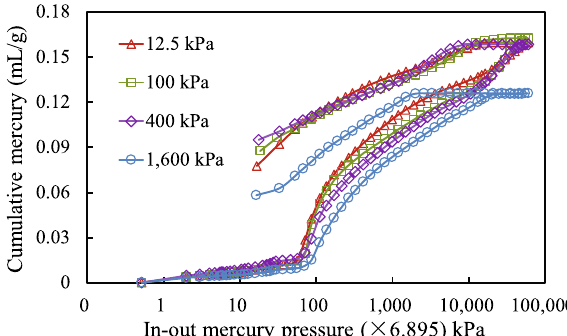
Figure 6. Relation between in–out mercury pressure and cumulative mercury.